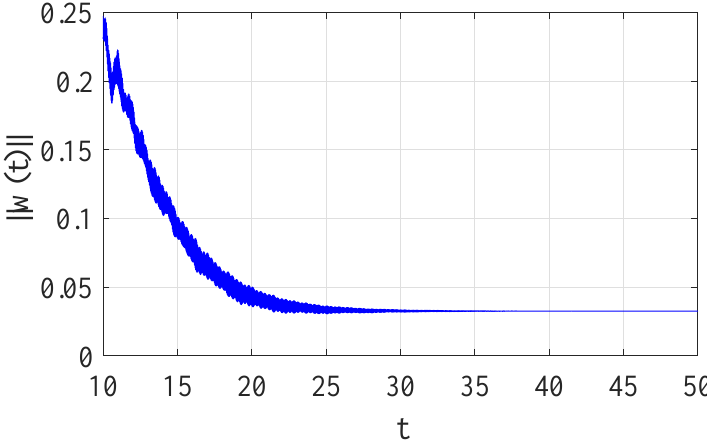
Figure 5. Error norm (cid:107) w ( t ) (cid:107) under controller (5) when γ =